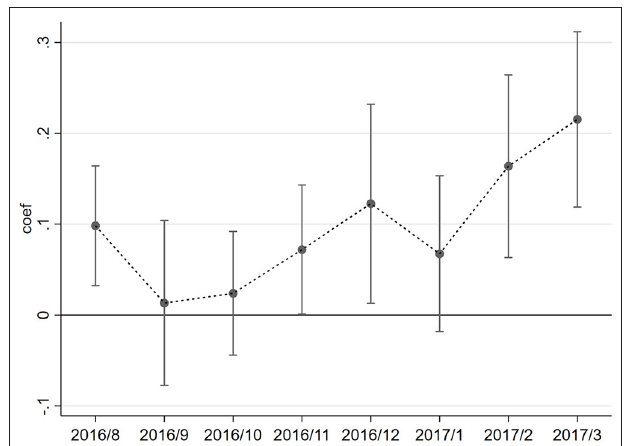
FIGURE 2 | Time trend of the cost variation factor by disease type.